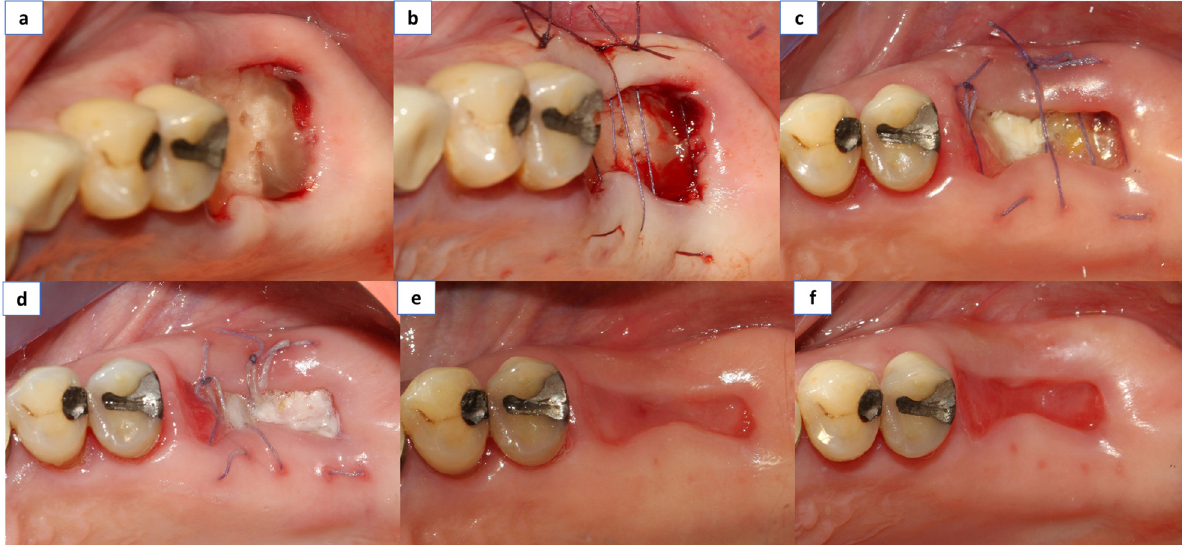
Figure 2. ( a ) The PRGF was applied within the socket and the membrane was laid above within the socket wall, ( b ) Suturing was done with resorbable material in all cases (Vycril_ 4/0, Ethicon, Inc., Somerville, New Jersey, US), ( c ) Clinical control at 3 days, ( d ) Clinical control at 7 days, and ( e ) Clinical control at 14 days. ( f ) Clinical control at 21 days.